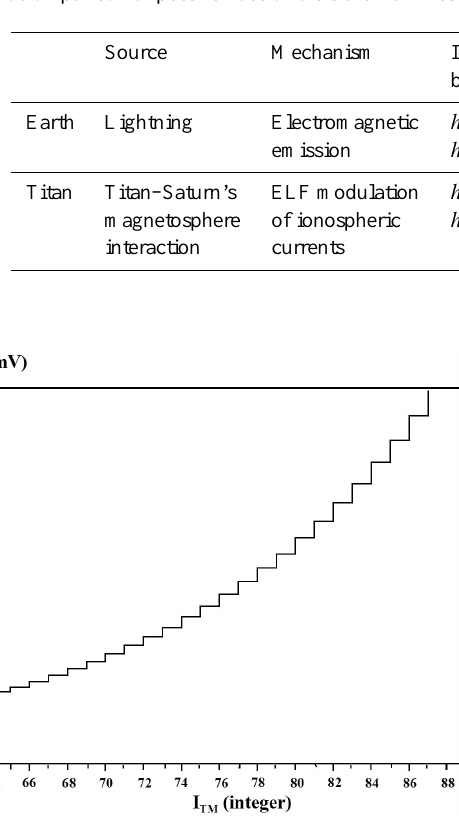
Fig. 1. Portion of the log-compressed transfer function V ADC versus I TM (Eq.